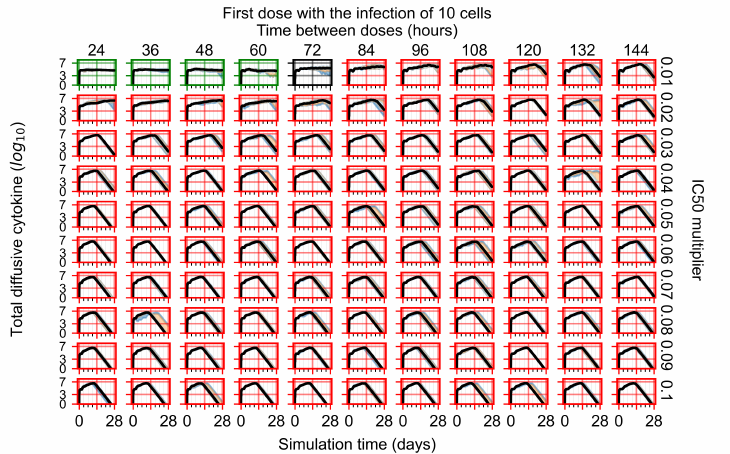
Figure A72. Diffusive cytokine amount, Y axis in log scale, and exponent values as tick marks.